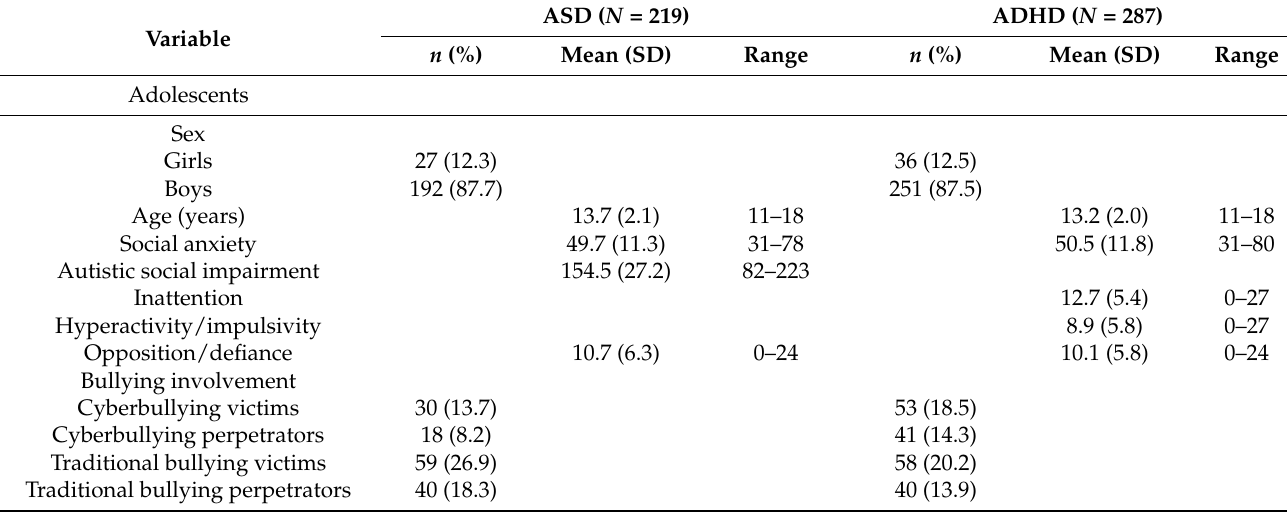
Table 1. Descriptive Statistics of Demographic Characteristics, Social Anxiety, Autistic Social Impairment, ADHD and Oppositional Defiant Symptoms, and Bullying Involvement in Adolescents with ASD and